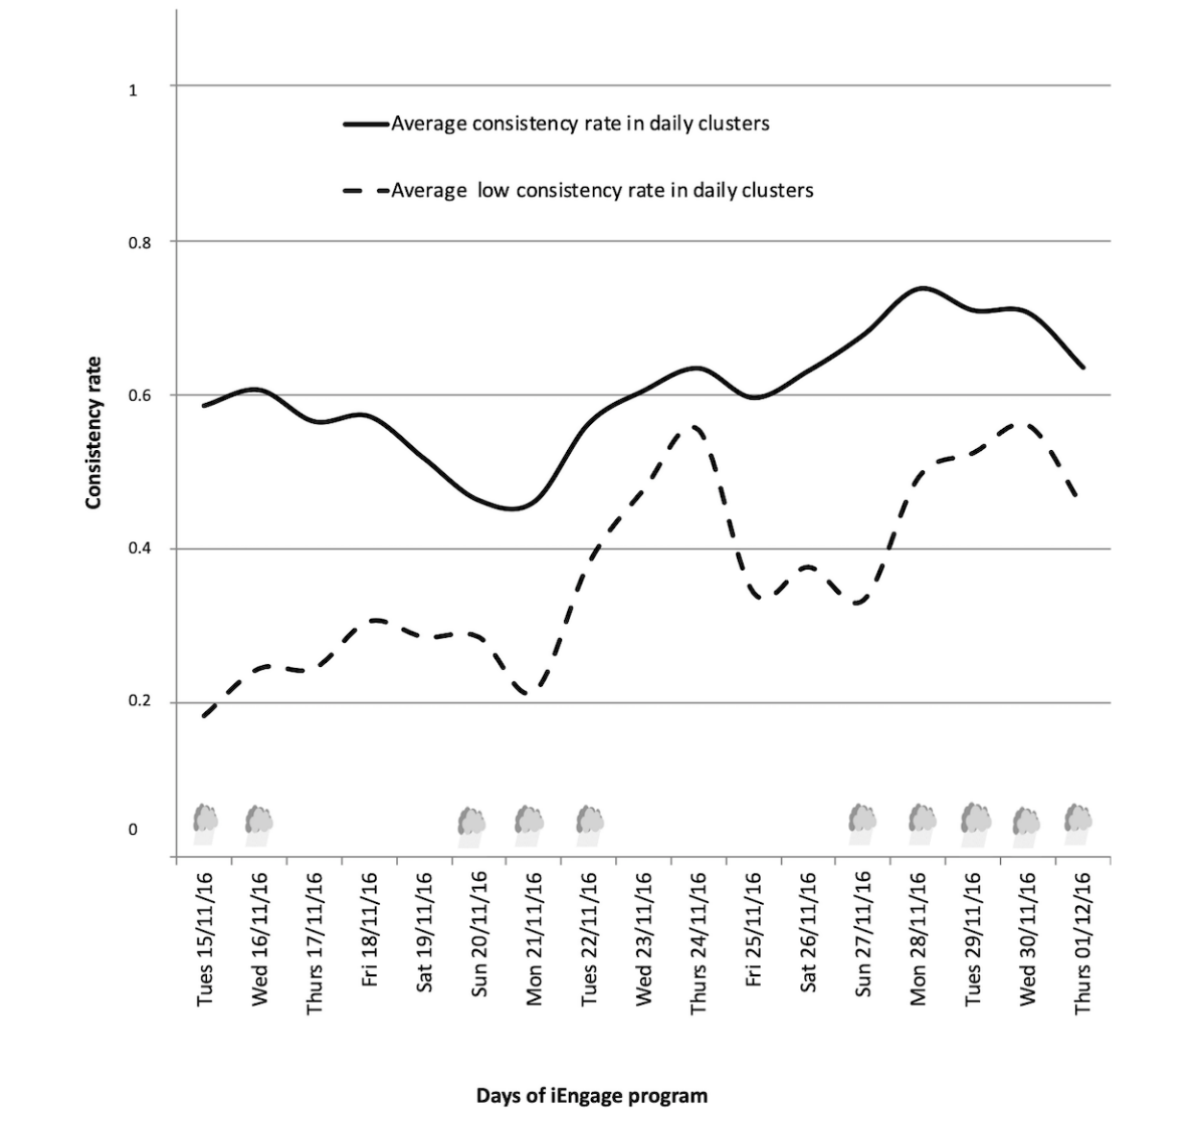
Figure 5. Average consistency rate (from 0 to 2) of daily behavior clusters during the iEngage program. Rainy days (N=10, between 0.3 and 14.3 mm.3h -1 ) are represented by a cloud